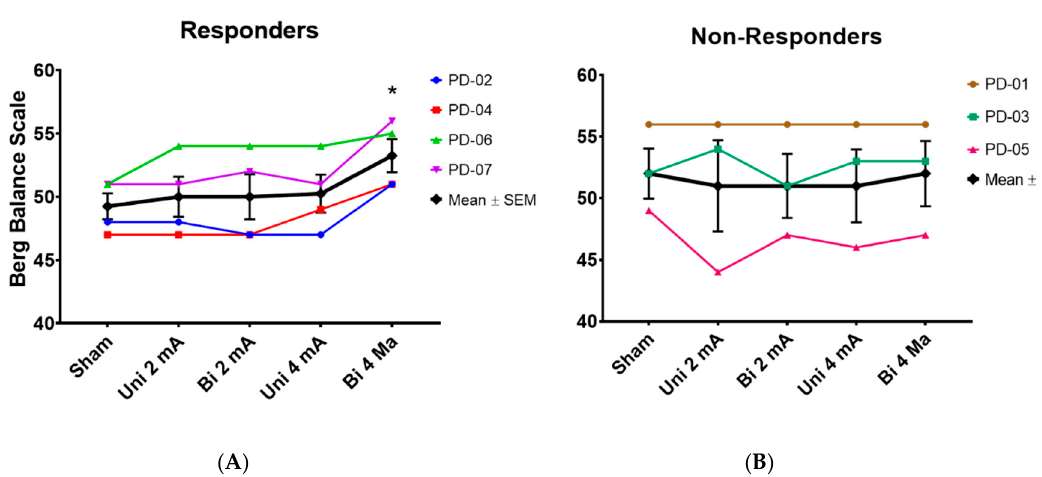
Figure 2. Berg Balance Scale scores in different transcranial direct current stimulation conditions for subjects classified as ‘responders’ ( A ) and ‘non-responders’ ( B ). * = Bi 4 mA significantly different from sham. Uni = unilateral montage; Bi = bilateral montage.